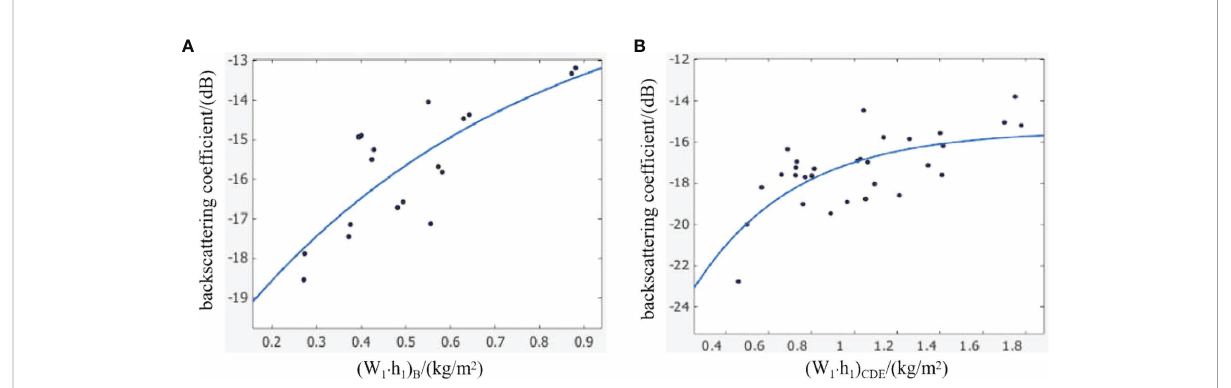
FIGURE 9 The relationship between the backscattering coef fi cients and W 1 ·h 1 under polarization HH. (A) is the relationship between the backscattering coef fi cients and W 1 ·h 1 under polarization HH in parcel B; (B) is the relationship between the backscattering coef fi cients and W 1 ·h 1 under polarization HH in parcel